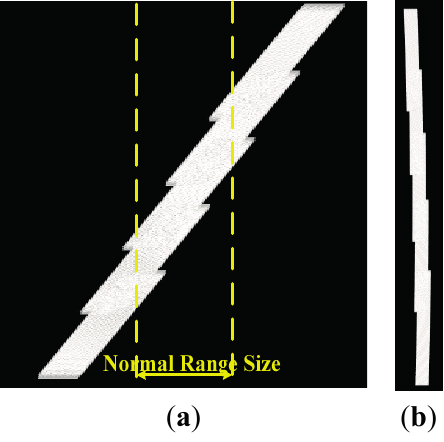
Figure 8. Processing results before the ANI. ( a ) Traditional algorithm; ( b ) Proposed